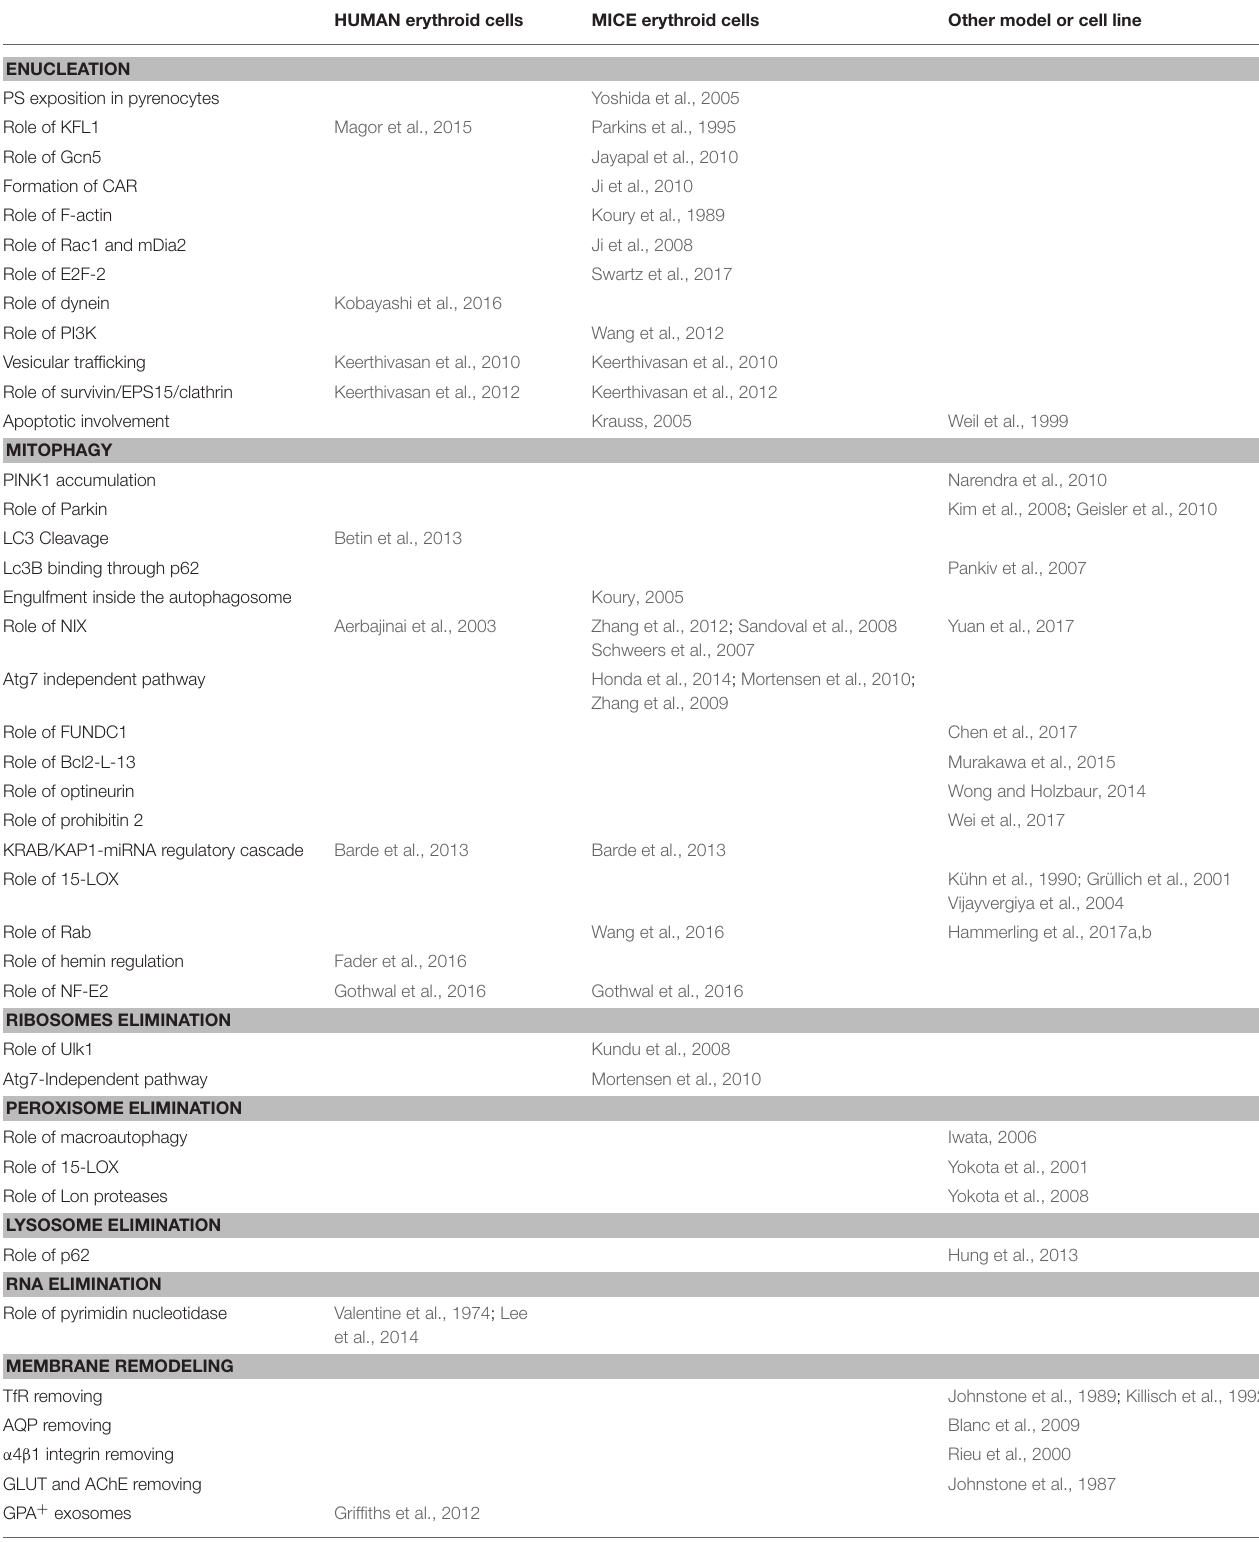
TABLE 1 | Comparison between studies in human or mice erythroid cells or in other cell